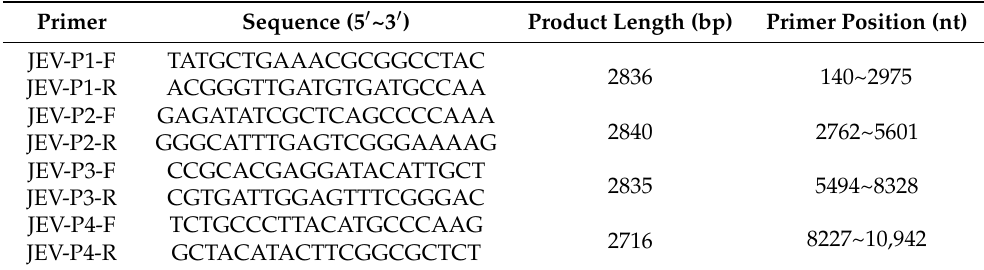
Table 1. Primers for JEV gene